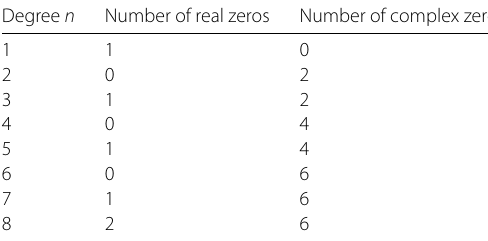
Table 9 Numbers of real and complex zeros of L e n ( x , y ) Degree n